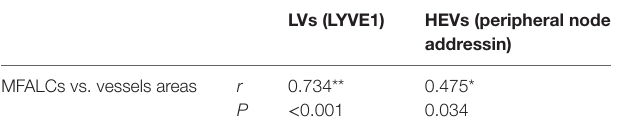
TaBle 4 | Correlation between area of mediastinal fat-associated lymphoid clusters (MFALCs) and the relative ratios of LVs or high endothelial venules (HEVs) in the MFALCs. lVs (lYVe1) heVs (peripheral node addressin) MFALCs vs. vessels areas